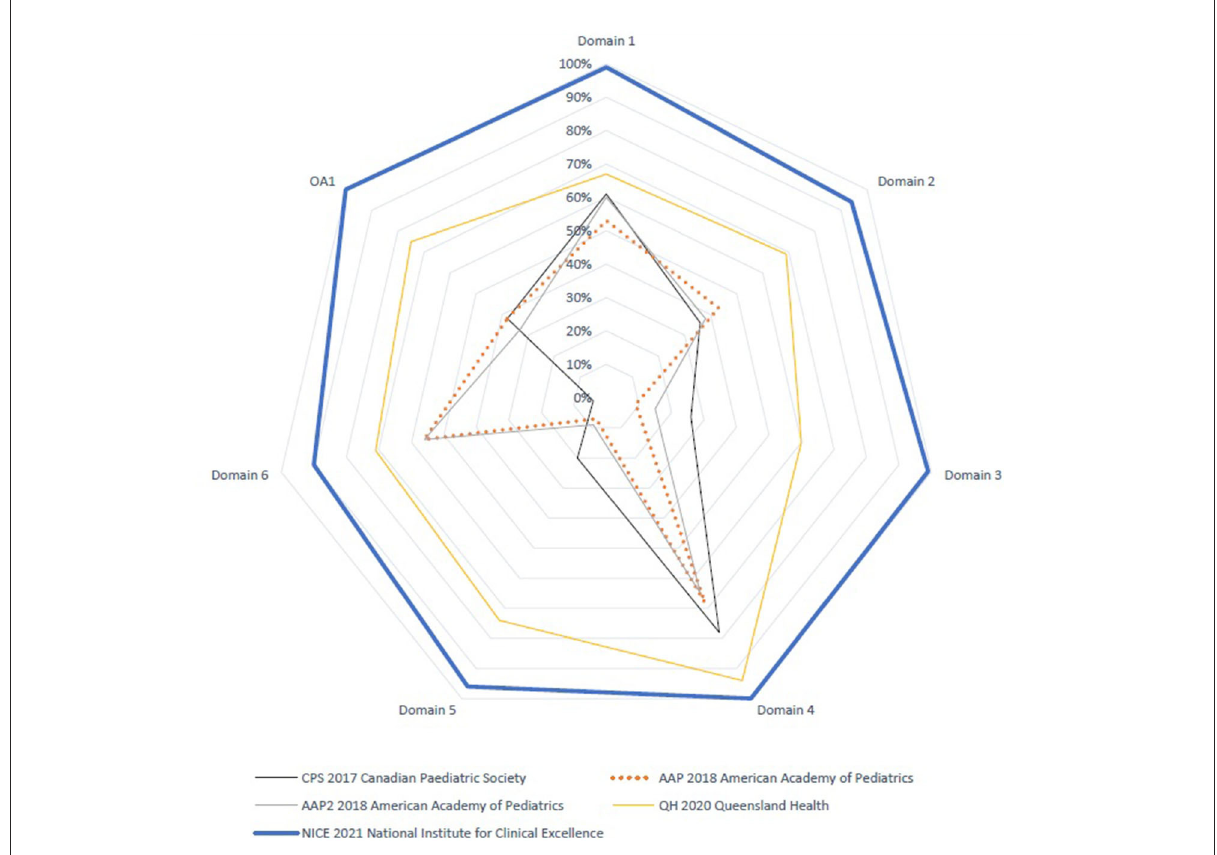
FIGURE1 AGREE II domains standardized scores for the five source